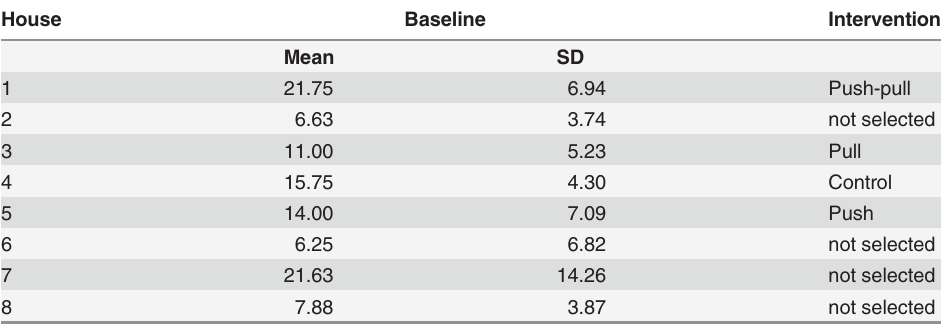
Table 1. Mean number (+SD) of mosquitoes caught during the baseline phase. House